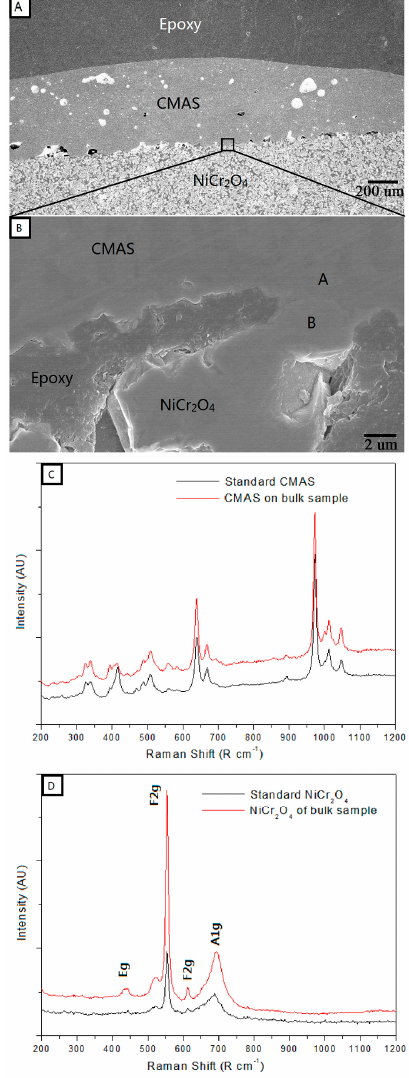
Figure 4. ( A ) Cross-sectional SEM micrographs of the NiCr 2 O 4 bulk sample that interacted with 35 mg/cm 2 CMAS at 1200 °C for 24 h and ( B ) a high magnification image of the CMAS-NiCr 2 O 4 boundary; ( C ) Raman spectra at the area marked A in ( B ) compared with standard CMAS and ( D ) at the area marked B in ( B ) compared with standard NiCr 2 O 4 .